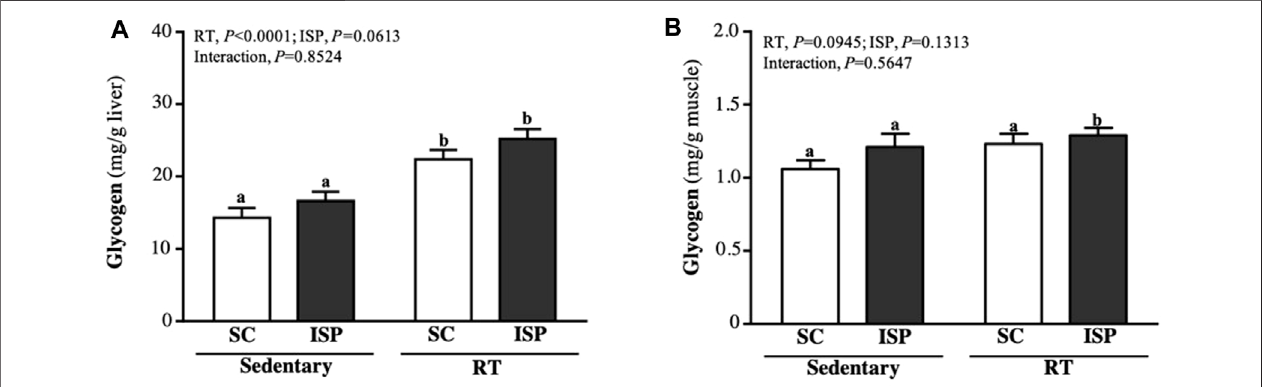
FIGURE5| EffectofISPsupplementationandRTofagingmiceon (A) liverglycogenand (B) muscleglycogen.Dataareexpressedasmean±SDfor n =8miceper group. Different superscript letters (a and b) indicate signi fi cant difference at p < 0.05.